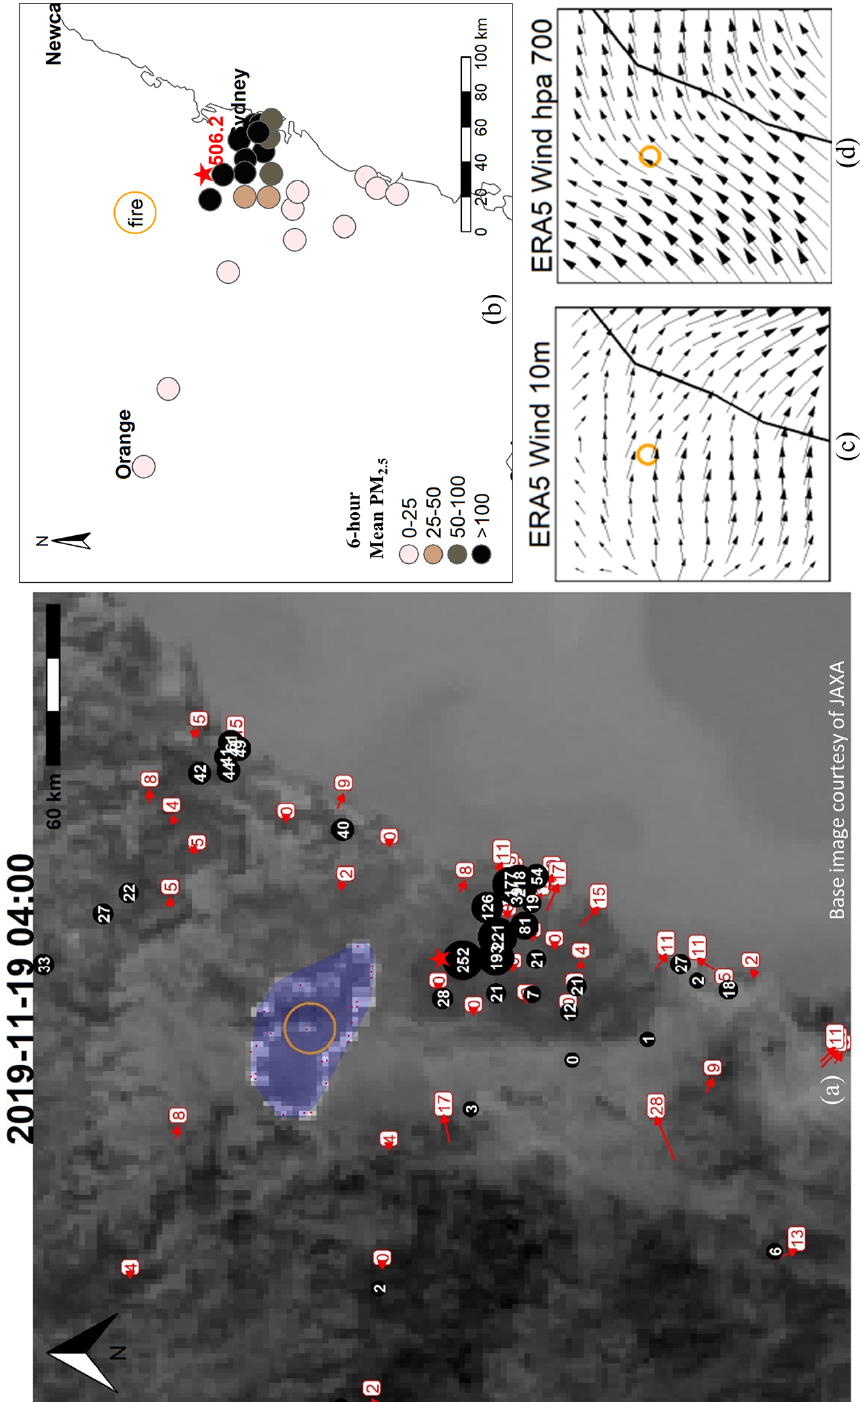
Figure A4. Wildfire morning. The highest mean morning WF PM 2 . 5 was 506.2µgm − 3 at Rouse Hill (red star), which was the second closest AQS at 30–40km from the fire. This was also the Gospers Mountain fire. Richmond AQS was closer but recorded a mean PM 2 . 5 of 112µgm − 3 . There were seven other AQSs with a mean > 100µgm − 3 for this period and another three > 50µgm − 3 (b) . It is not apparent from the BOM wind (red arrows in a ) or the ERA5 data (c, d) that wind flowed directly from the fire to Rouse Hill. The high values may be the result of smoke lingering from the previous day (Fig. A2). However, smoke appeared to clear out during the night period preceding this morning, as the night had comparatively low PM 2 . 5 values (all Sydney AQSs < 25µgm − 3 ). There may have been drainage flows from the mountains into the Sydney basin that were not captured in the weather data. After this morning, winds turned westerly and then southerly, which pushed smoke away from Sydney and reduced PM 2 . 5 < 25µgm − 3 across